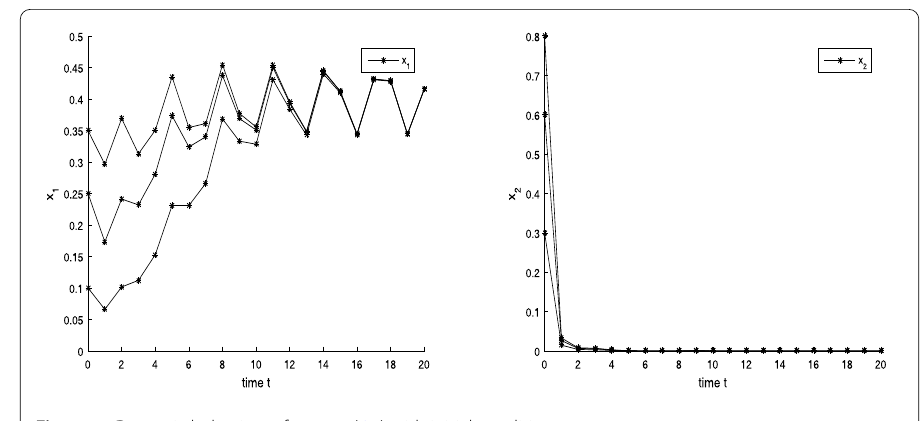
Figure 4 Dynamic behaviors of system (6.4) with initial condition ( x 1 ( t ), x 2 ( t )) T = (0.1,0.8) T ,(0.25,0.6) T ,(0.35,0.3)